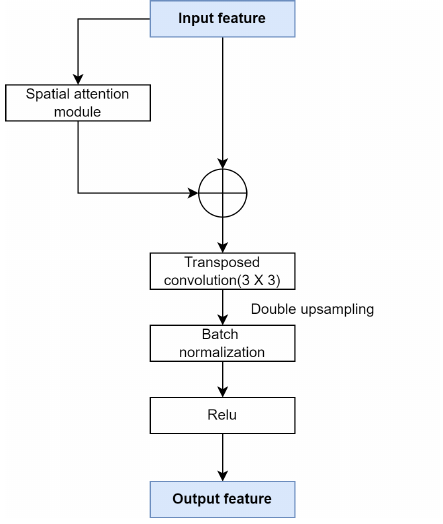
Figure 4. Spatial attention deconvolution